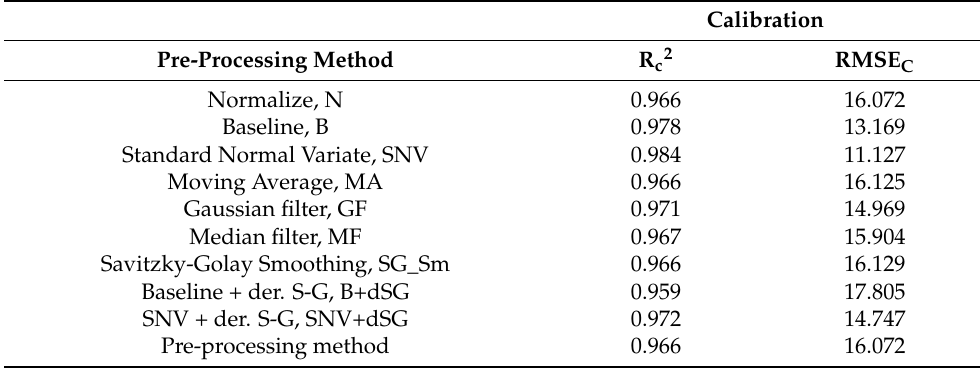
Table 2. Results of model evaluation parameters (R 2 and RMSE) for different preprocessing methods used for calibration data (model M1 in the range of 1140–1618 cm − 1 ).